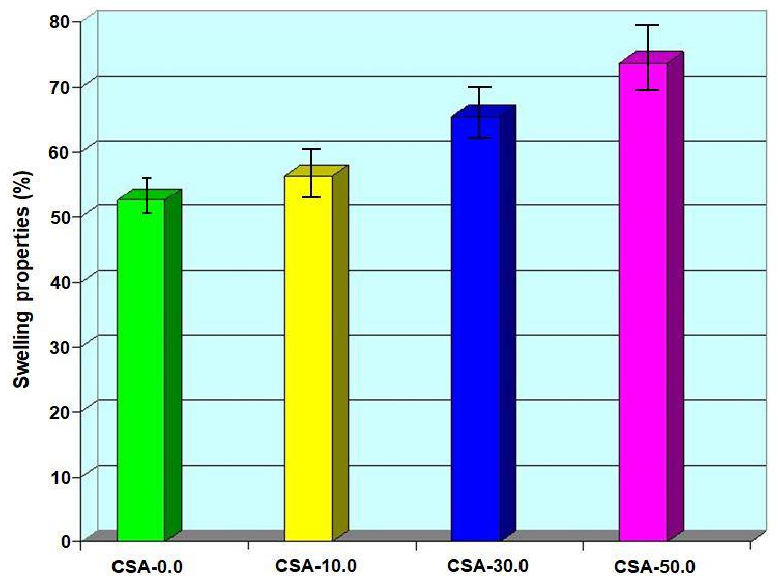
± 5.01 standard errors.